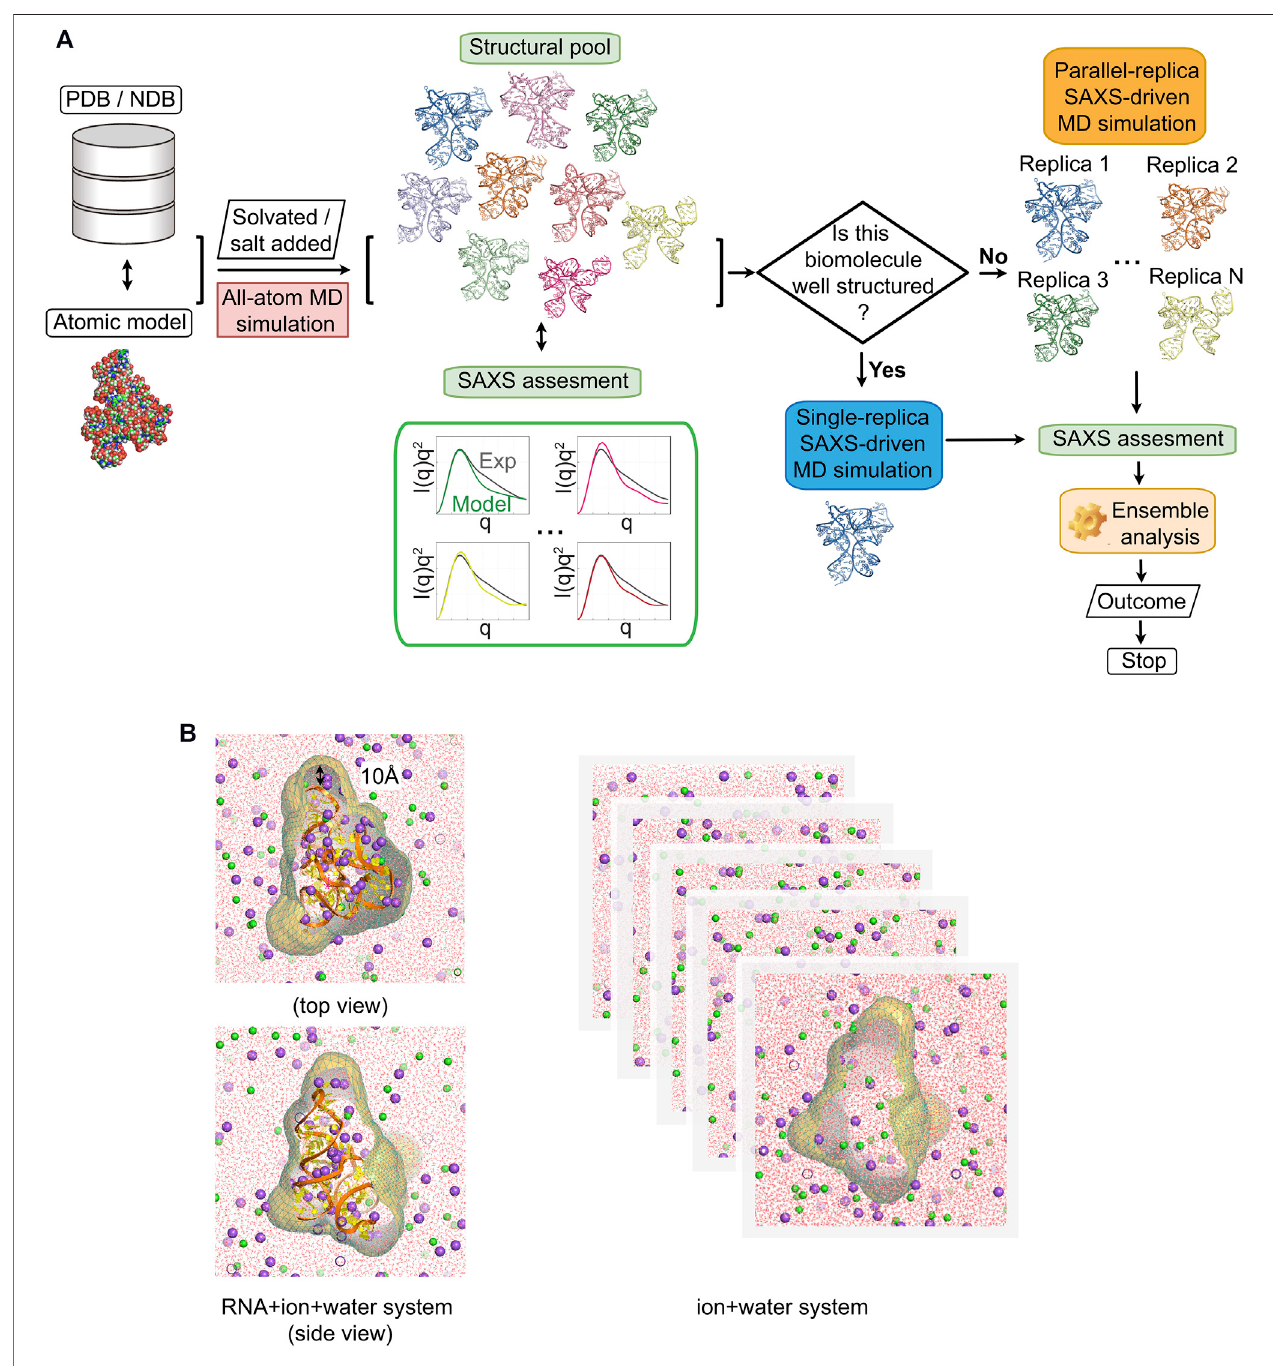
FIGURE 1 | Flowchart of generating experimentally consistent RNA structures using small-angle x-ray scattering (SAXS) data. (A) The atomic model of target biomolecule is built or taken PDB/NDB. The step of the SAXS assessment after molecular modeling sorts the structure pool and picks out the best- fi t conformations determined by the agreement (the threshold χ 2 ≤ 20). Different SAXS-driven strategies are used depending on RNA: a single-replica protocol for RNAs that are relatively well-structured, parallel-replica protocol for fl exible RNA constructs. (B) Illustration of the RNA + ion + water and water + ion systems used to compute SAXS. The molecular envelope is constructed from a three-dimensional probability density isosurface 10 Å from the molecular surface to encompass the solvent/ion shell. The scattering intensity of the water + ion system was computed by applying the same envelope. We subtract the scattering from the RNA-ion system from solvent as described in Section 2